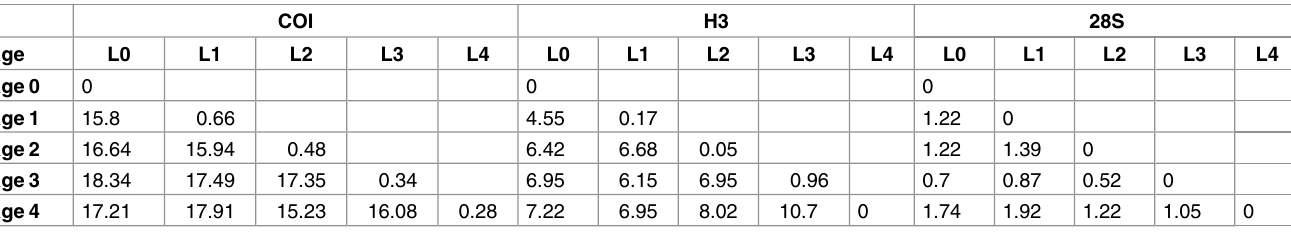
Table 2. Mean genetic distances (observed p-distances in %) of Parisotoma notabilis in Europe for three genes.